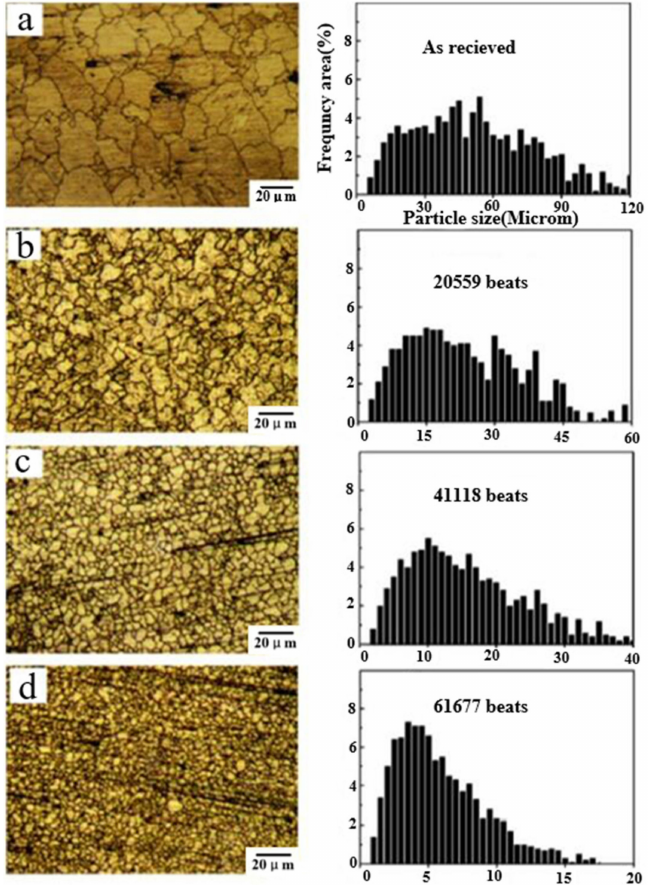
Figure 13. Microstructure and grain distribution under different ultrasonic shot peening times. ( a ) Original material; ( b ) after 20,559 beats ultrasonic peening; ( c ) after 41,118 beats ultrasonic peening; ( d ) after 61,677 beats ultrasonic peening [78].